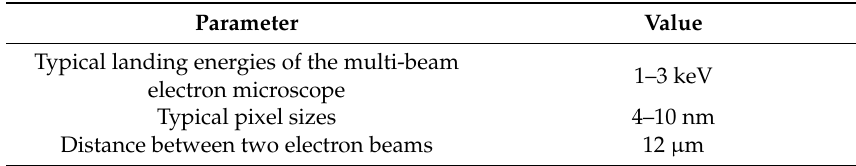
Table 3. Comparison of Technologies.